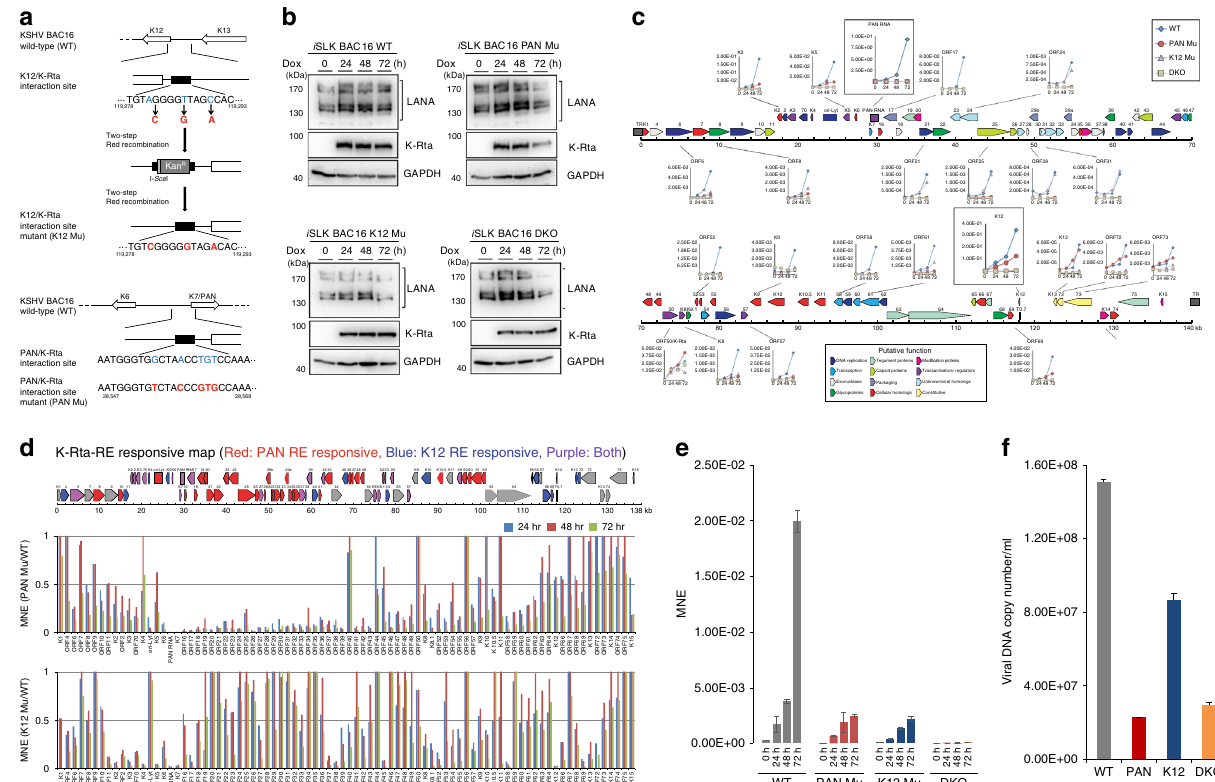
Fig. 4 A K-Rta direct response element (RE) essential to coordinating regulation of KSHV gene clusters and reactivation. a Bacmid construction. Scheme of two-step red recombination for the construction of the KSHV K-Rta RE mutants used in this study: PAN Mu, K12 Mu, and PAN + K12 DKO. b Immunoblot analysis for KSHV gene products in i SLK BAC16 cell lines containing wild type and mutant KSHV bacmid clones. c Time course of KSHV gene expression in i SLK BAC16 cell lines. A map of the KSHV ORFs and their putative functions is shown. RT-qPCR expression analysis was performed for the indicated ORFs in WT (blue diamond) and PAN Mu (red circle), K12 Mu (purple triangle), and DKO (brown square) mutant lines. Values are mean normalized expression (MNE) using ACTB as reference. PAN RNA and K12 expression is presented as insets. Complete KSHV gene expression signatures are presented in Supplementary Fig. 3. d Mapping of genomic domains by viral gene expression. Normalized viral gene expression in each mutant KSHV (PAN Mu, K12 Mu) was compared with that of wild type at each time point to reveal dependency on K-Rta direct binding to the PAN RE (middle panel) and K12 RE (bottom panel). A gene exhibiting > 50% reduction in expression at all time points (24 h, blue; 48 h, magenta; 72 h, green) during reactivation was considered as responsive. Values represent MNE relative to BAC16 WT (1 = unchanged). The upper panel summarizes genes regulated by PAN RE (red), K12 (blue), or both (purple). Genes unaffected by the effects of the mutations are marked in gray. Gene expression not evaluated was marked in black (ORF65). e Endogenous K-Rta gene expression. Endogenous K-Rta expression in i SLK BAC16 lines was measured using a gene-speci fi c primer for reverse transcription, followed by qPCR. Values represent MNE ± SD ( n = 3). All 72 h means differ signi fi cantly ( p < 0.01; one-way ANOVA with Tukey ’ s post-hoc HSD test). f KSHV replication. Encapsidated KSHV DNA in culture supernatant 5 days post-reactivation was measured by qPCR. Values represent copy number/ml (mean ± SD, n = 3). All means differ signi fi cantly in pairwise comparisons ( p < 0.01; one-way ANOVA with Tukey ’ s post-hoc HSD test), except PAN Mu vs.